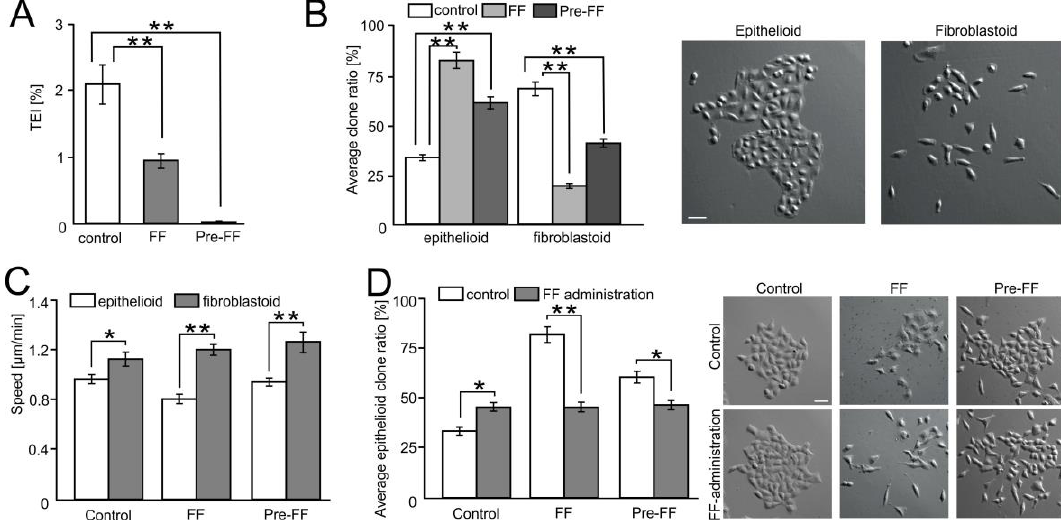
Figure 6. FF selectively impairs the transendothelial migration of fibroblastoid A549 cells. ( A ) A549 cells were seeded on microporous membranes covered by control or FF-pretreated (Pre-FF) HUVEC monolayers, cultivated for 24 h in control conditions or in the presence of 25 μM FF (FF), and the fraction of transmigrated cells was estimated (TransEndothelial penetration Index (TEI)). ( B ) Morphology of A549 microclones derived from the cells that transmigrated through HUVEC-covered microporous membranes in the same conditions as in A. ( C ) Motility of A549 progenies derived from the cells that transmigrated through HUVEC-covered microporous membranes in the same conditions as in A. ( D ) Progenies derived from A549 cells that most readily transmigrated through HUVEC monolayers were treated with FF, and their morphology and the fraction of epithelioid clones was estimated after 72 h. Error bars represent SEM. The statistical significance of the differences was tested with one-way ANOVA followed by post-hoc Tukey’s HSD ( A , B , D ) or non-parametric Dunnett comparison ( C ); * p < 0.05; ** p < 0.01. All results are representative of at least three independent experiments ( n ≥ 3). Scale bar = 40 µ m. Note the differential effect of FF on the transmigration of “fibroblastoid” and “epithelioid” A549 cells.